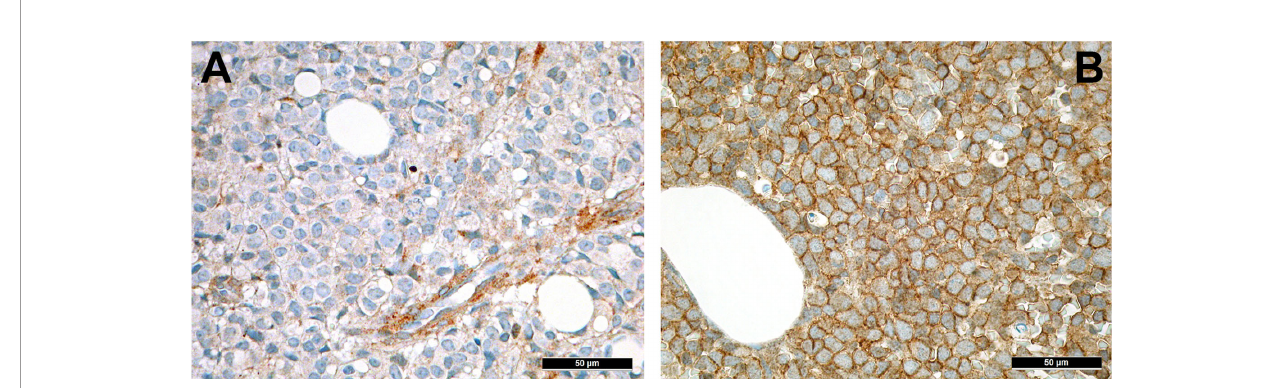
FIGURE 5 | Expression of members of the CXCL12-CXCR4 axis in AML. (A) Expression of CXCL12 in perivascular MSC-equivalents in AML (immunohistochemistry, 400x); (B) Diffuse expression of the receptor of CXCL12, CXCR4, on AML blasts (immunohistochemistry,